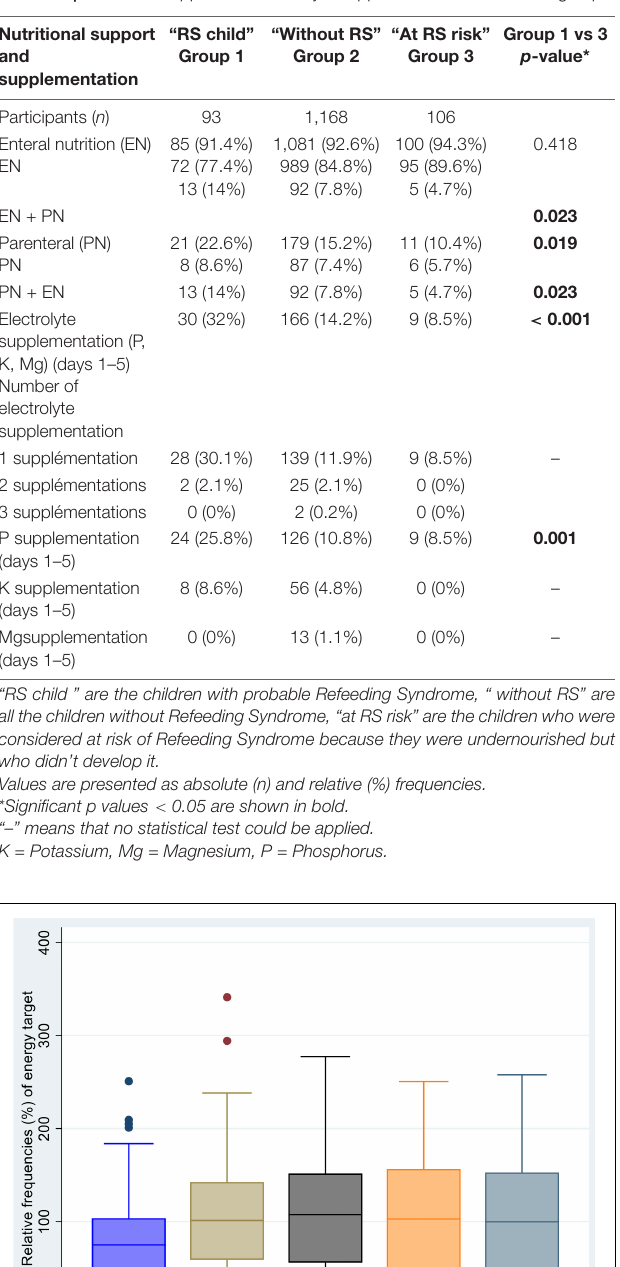
TABLE 3 | Nutritional support and electrolyte supplementation in the three groups.